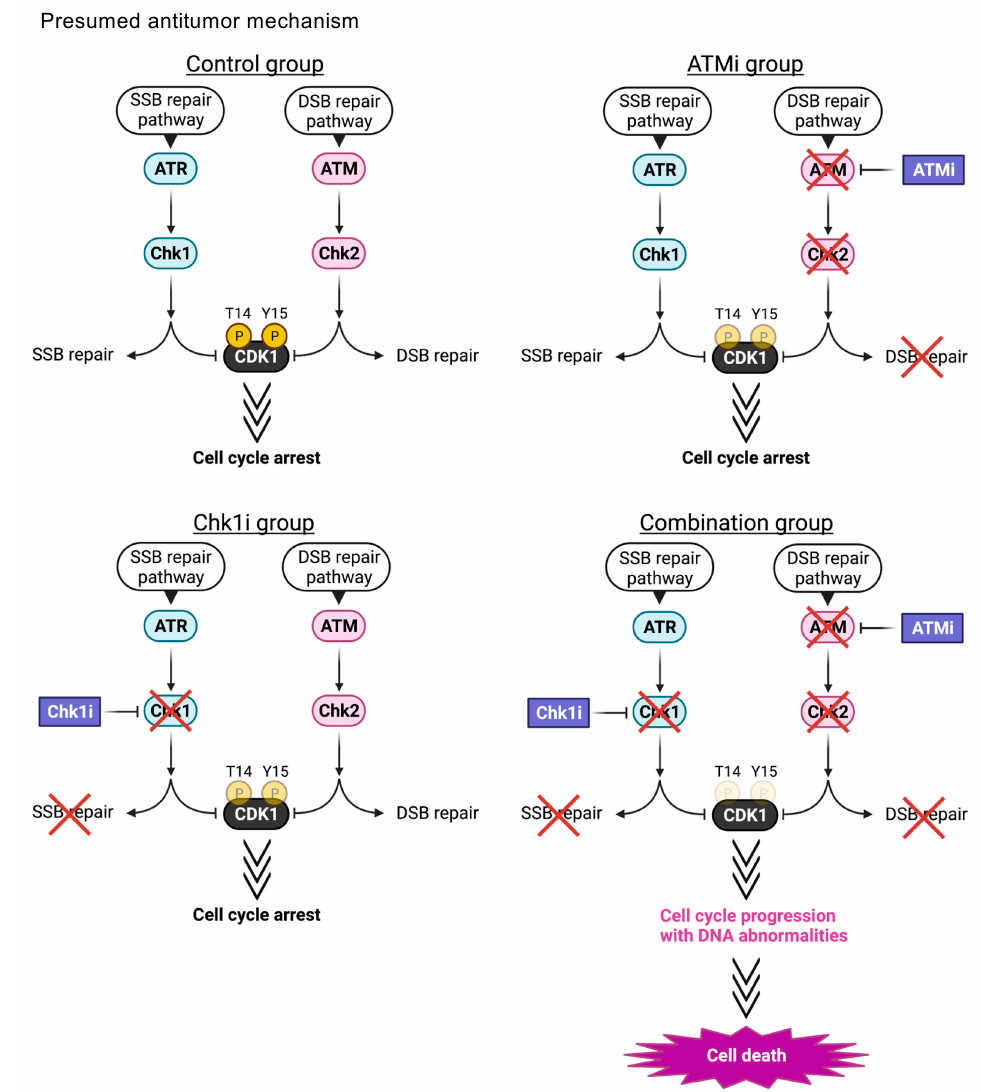
Figure 6. Presumed antitumor mechanism. Putative mechanism of ATMi- and Chk1i-induced synthetic lethality in colorectal cancer cells.